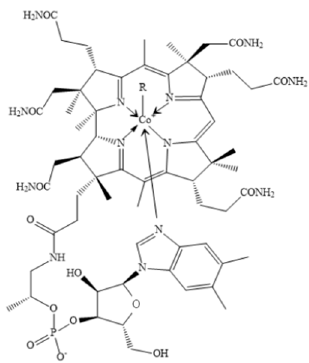
Figure 1. The chemical formula of VB12. R = 5 ′ -deoxyadenosyl, CH3, OH, CN.